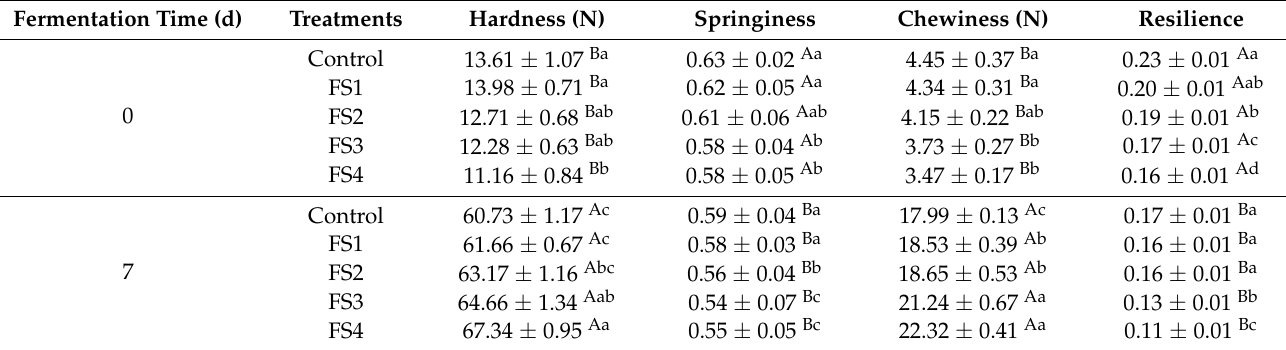
Table 5. Changes in texture profile analysis (TPA) of Harbin dry sausages with different replacement levels of CFS during fermentation. Fermentation Time